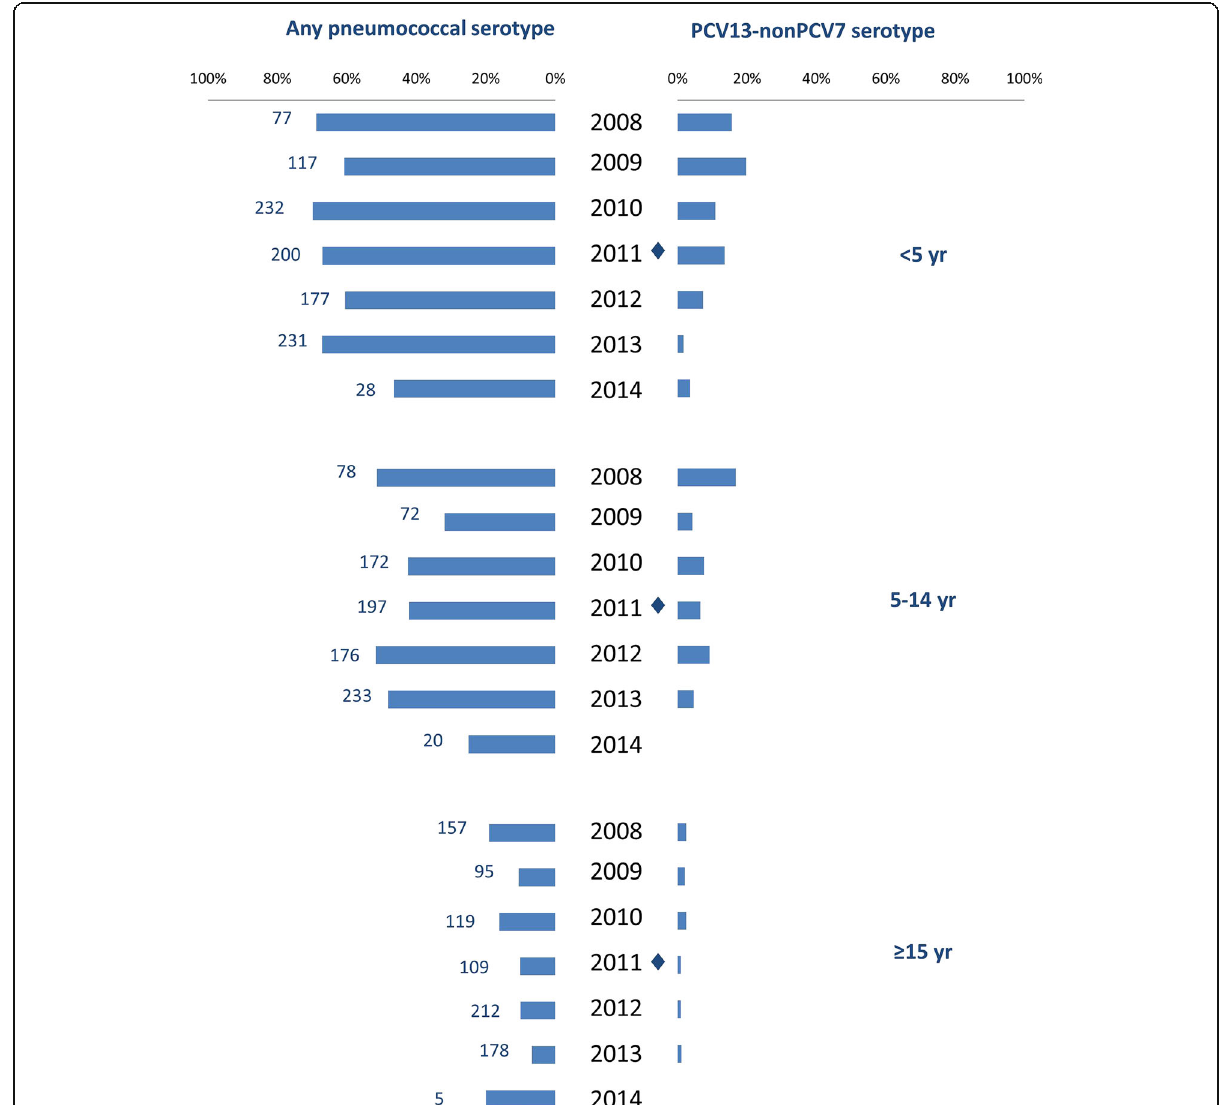
Fig. 1 Prevalence of any serotypeable pneumococcus or PCV13-nonPCV7 serotype only by year, by age group, among Aboriginal people in Western Australia, August 2008 – November 2014. Numbers by bars represent number of participants per year. ◆ PCV13 was introduced on 1 July